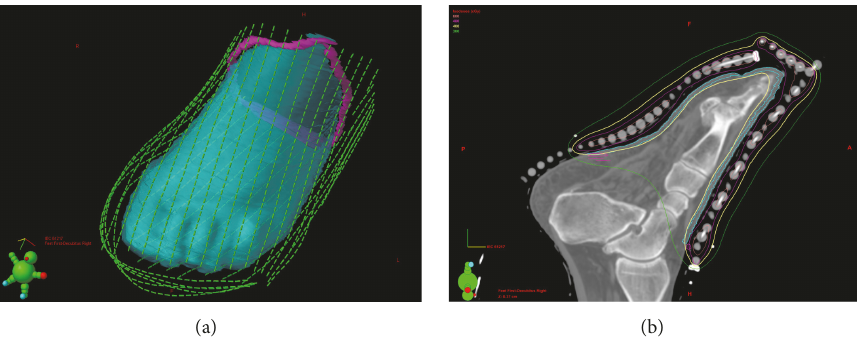
Figure 3: (a) Left foot treatment plan: 3D view of source dwell positions. (b) Left foot treatment plan: cutaneous planning treatment volume is shown in cyan, and the delivery of a highly conformal 4 Gy of radiation is shown in yellow isodose